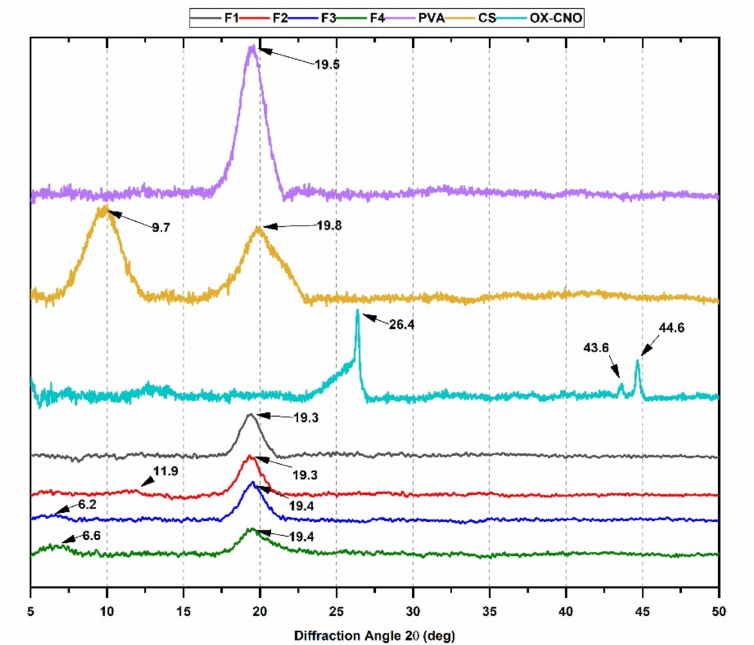
Figure 2. X-ray diffraction (XRD) analysis of CS/PVA/ox-CNO formulations: F1 (CS:PVA:ox-CNO 8:92:0); F2 (CS:PVA:ox-CNO 8:91:1); F3 (CS:PVA:ox-CNO 3.5:95.5:1); F4 (CS:PVA:ox-CNO 5.4:92.6:2); CS, PVA, and ox-CNO.